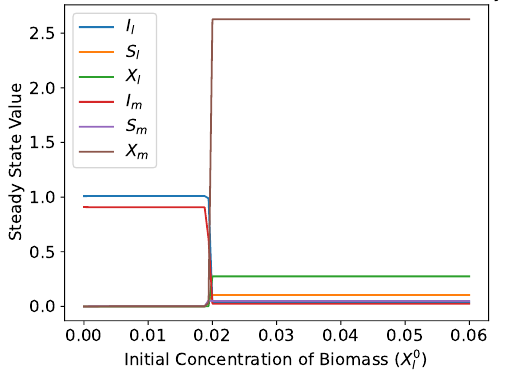
Figure 5. The effect of initial concentration of lumen biomass concentration ( X l ,0 ) on steady state concentration values in the dual compartment